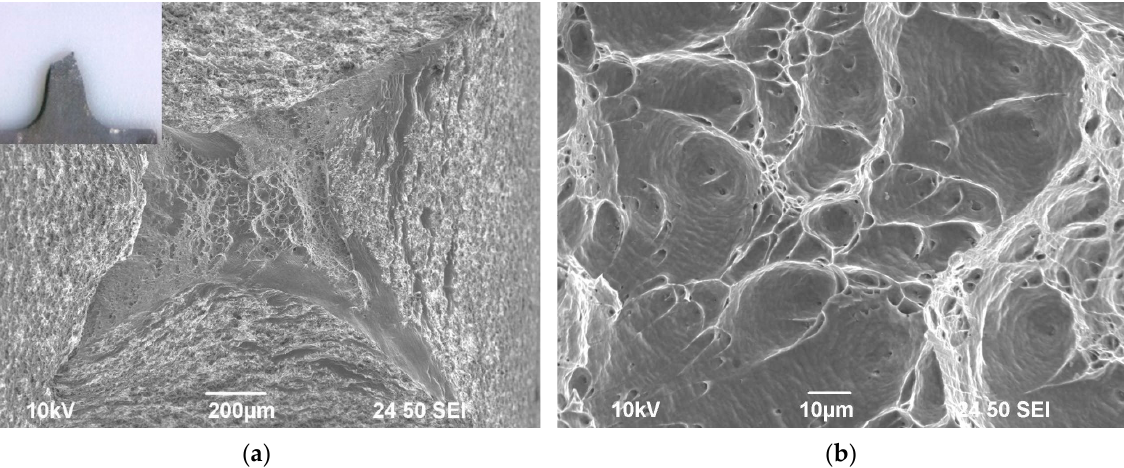
Figure 3. SEM images of fracture surfaces in specimen No. 5 after tensile tests at room temperature. ( a ) offers a general view of the fracture, while ( b ) shows an enlarged image of the central part of the fracture.